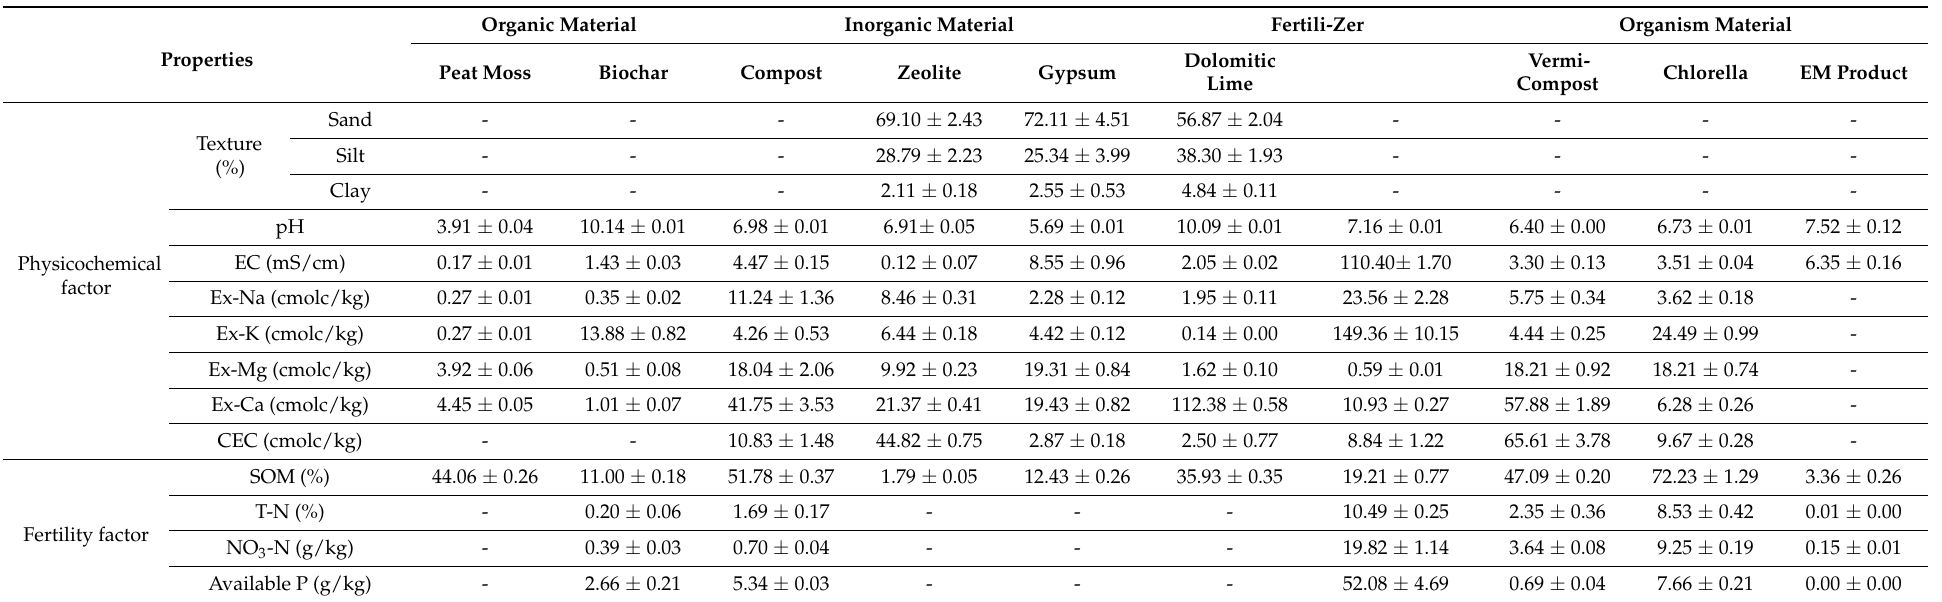
Table 1. Properties of amendments